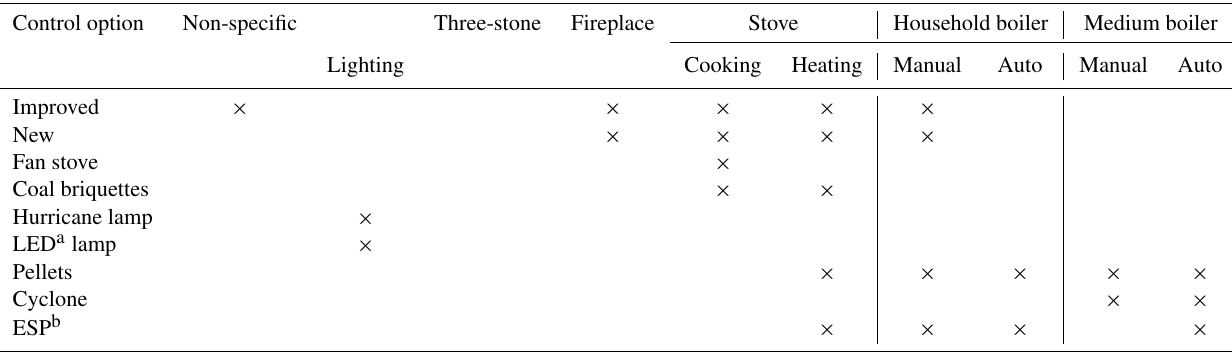
Table 3. Mitigation measures distinguished in the residential–commercial sector in GAINS. Control option